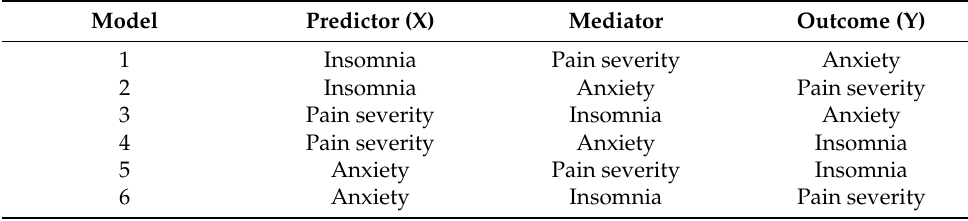
Table 1. Causal models tested.